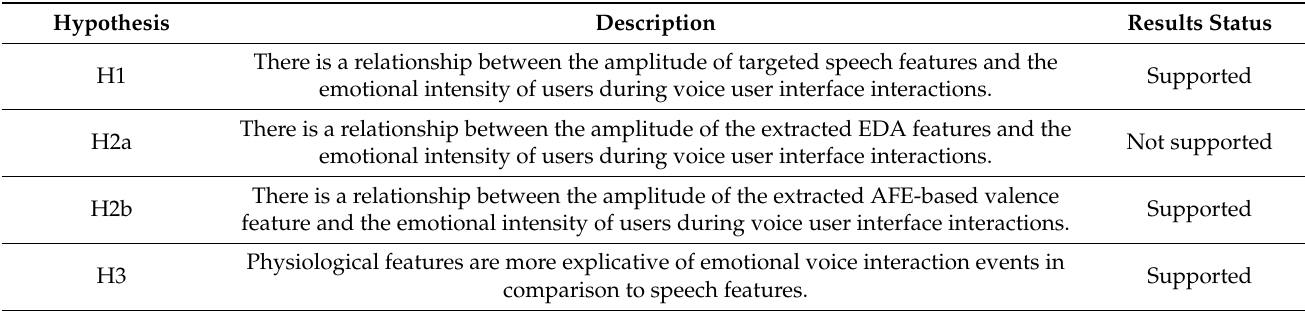
Table 9. Summary of hypotheses in relation to results